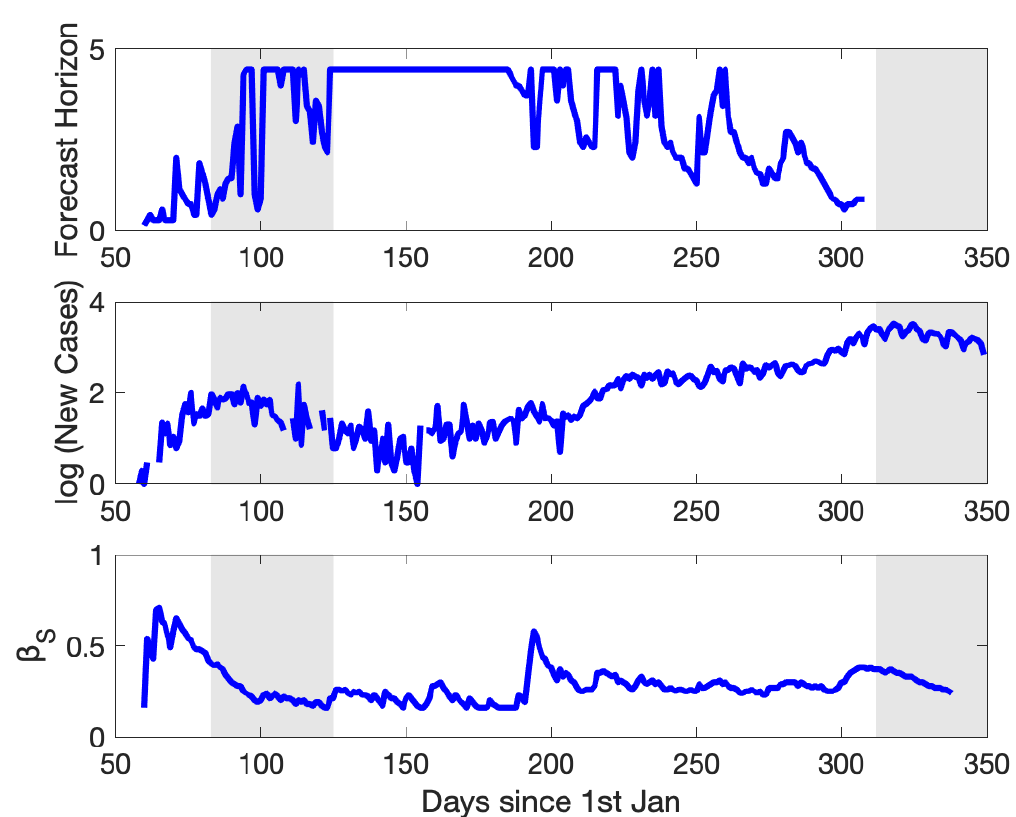
Figure 7. The forecast horizon and its variability (top panel), together with the evolution of the new cases (middle; from observations) and the β S (bottom panel). The lockdown periods are shaded. See text for explanation.